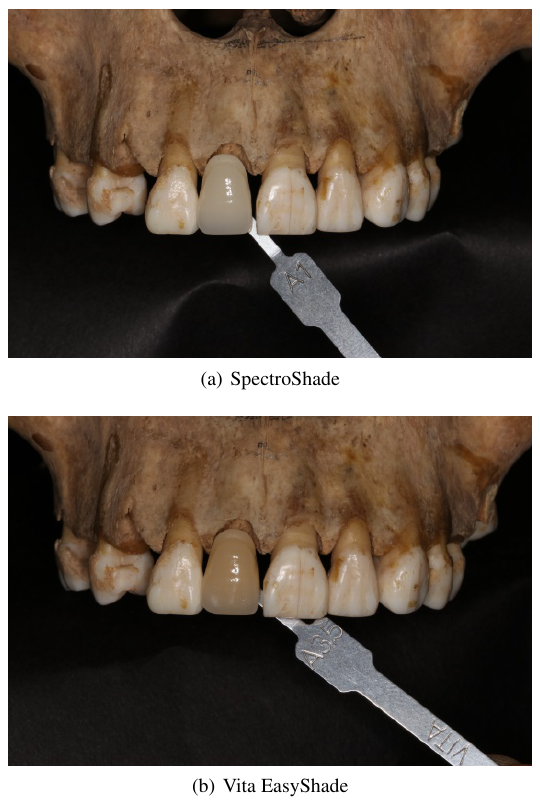
Figure 2. Vita Classic shade-guide samples positioned according to colour matching by SpectroShade (a) and Vita EasyShade (b); skull VIII-7-2.